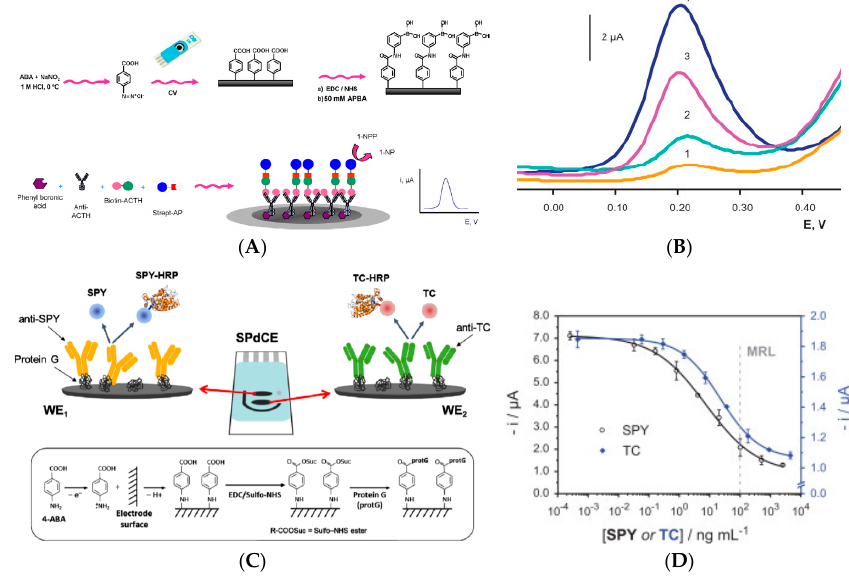
Figure 2. ( A ) Reactions involved in the ACTH immunosensor using SPEs modified with phenylboronic acid; ( B ) DPV obtained with the Strept-AlkP–Biotin-ACTH/anti-ACTH/SPCE electrode for 0 (1), 0.05 (2), 0.50 (3), and 1.00 (4) pg mL − 1 ACTH. Reprinted from [16], Copyright 2012, with permission from Elsevier; ( C ) Above, scheme of the immunosensor principle for SA and TC